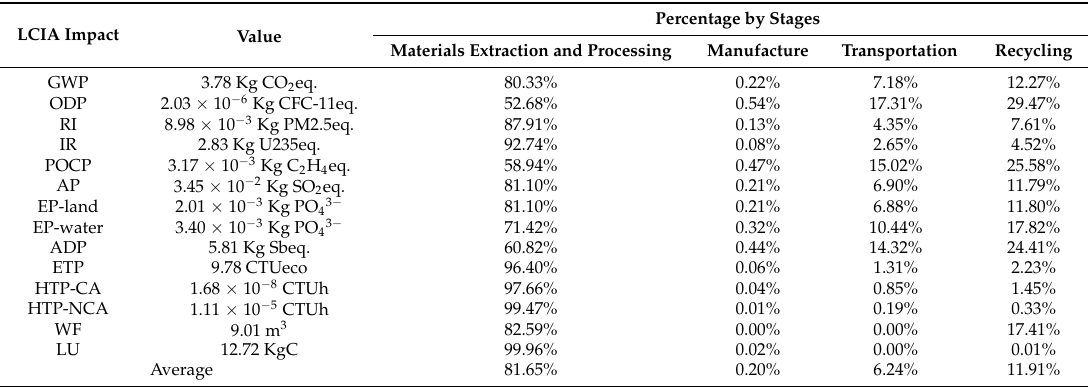
Table 4. The life cycle burdens for 1 KVAh capacity of LABs.